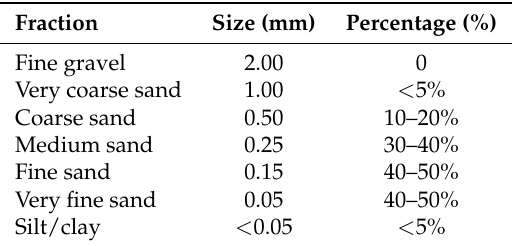
Table 1. Recommended sand particle sizes and percentage for greyhound racing surfaces.